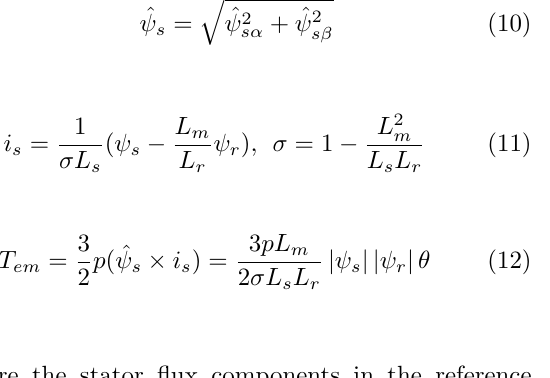
Fig. 9: Effect of vector v l on Ψ s s [28].